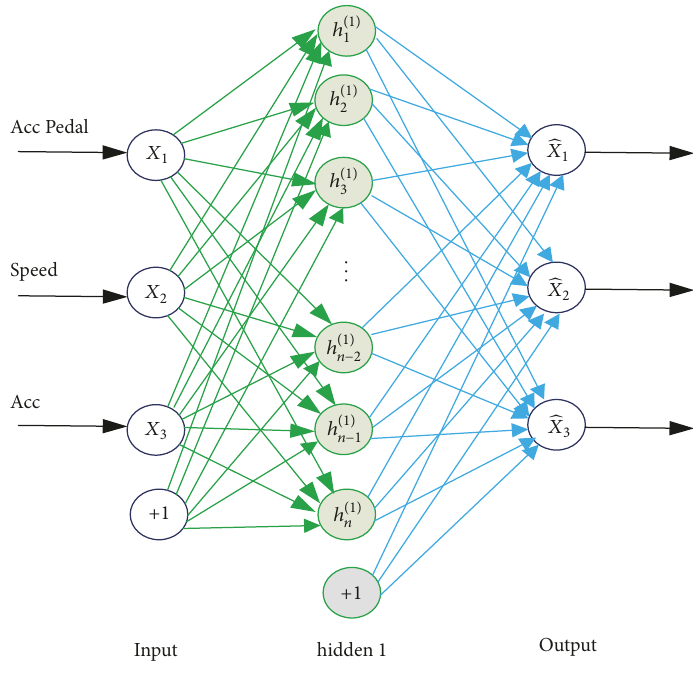
Figure 5: Training of hidden layer